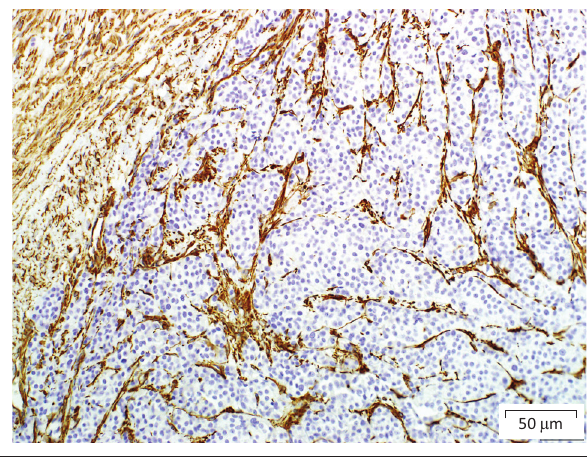
haematoxylin counterstain. FIGURE 5: Renal paraganglioma. Fibrous connective tissue capsule and stroma labelled with vimentin (an intermediate filament protein that is expressed in mesenchymal cells), but the neoplastic cells did not, indicating that these cells were unlikely to be of mesenchymal origin.